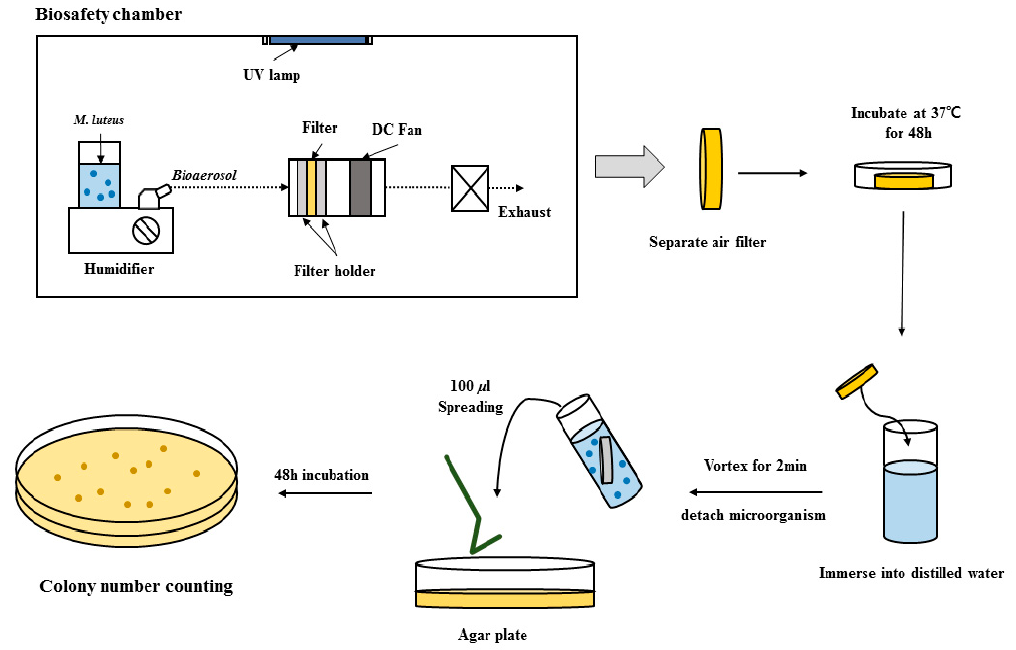
Figure 1. Schematic illustration of the experimental process for air filter antimicrobial testing.